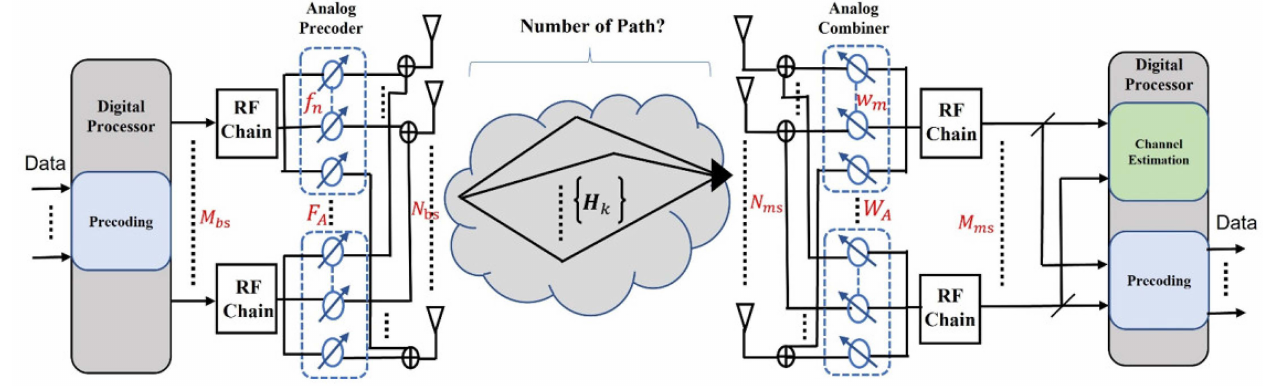
Figure 1. Architecture of the proposed Hybrid-MIMO